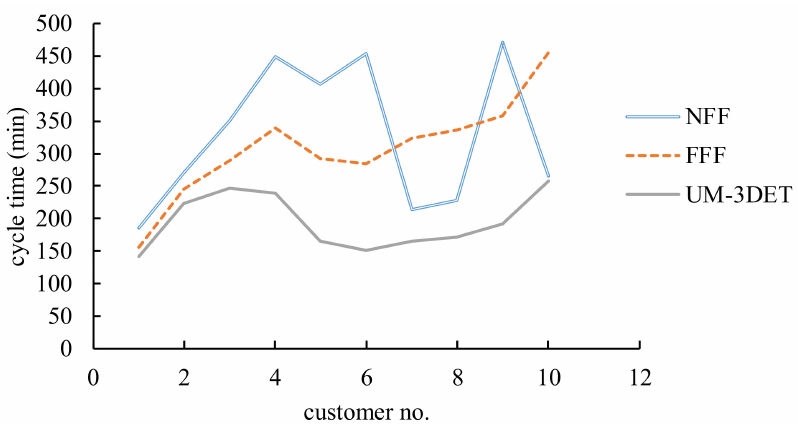
Figure 6. Manufacturing lead times achieved using various methods.